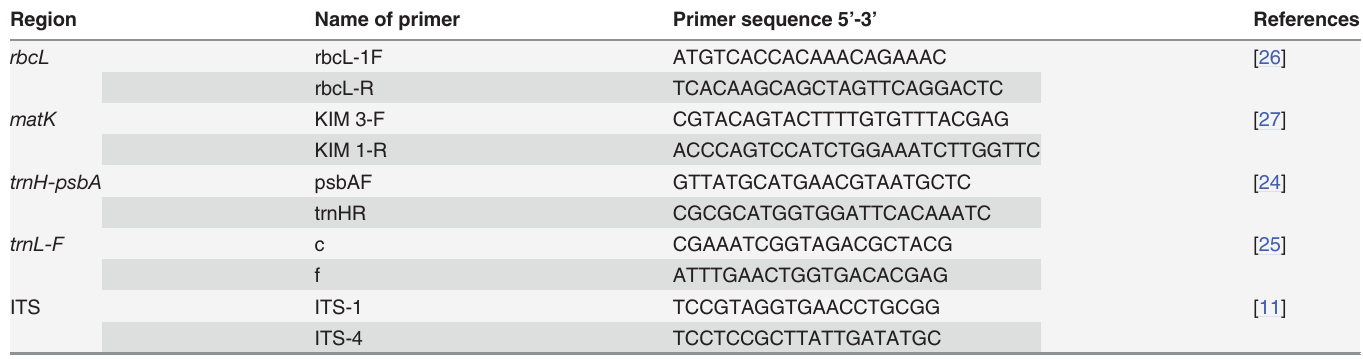
Table 1. PCR primers and references used in the present study.